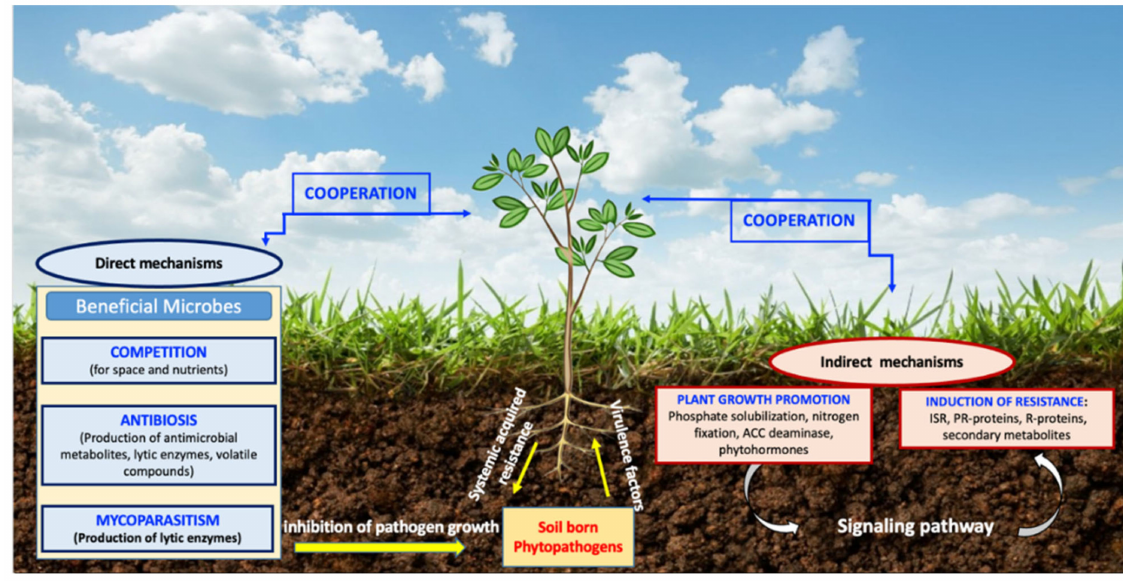
Figure 2. Possible modes of action of biological control